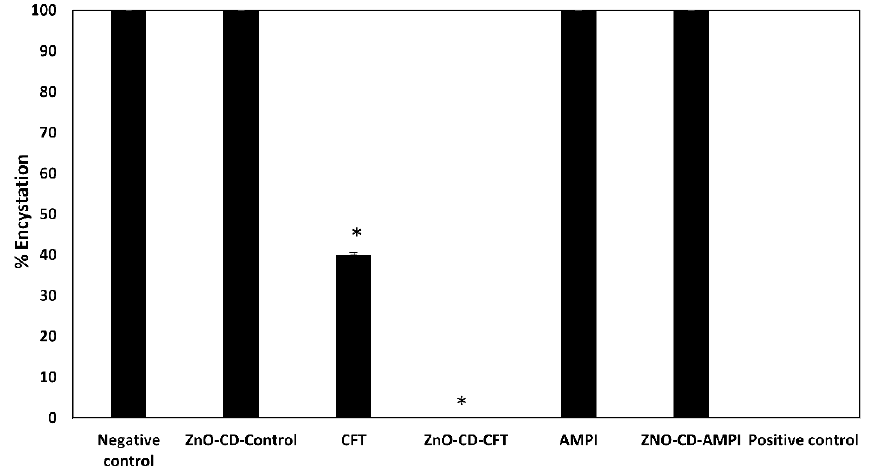
Figure 4. To determine whether the utilized compounds inhibited A. castellanii encystation, encystment assays were carried out. The results revealed that the CFT and ZnO-CD-CFT markedly inhibited encystment at a concentration of 100 µ g/mL in 48 h incubation. The data are presented as the mean ± standard error (* is p < 0.05).